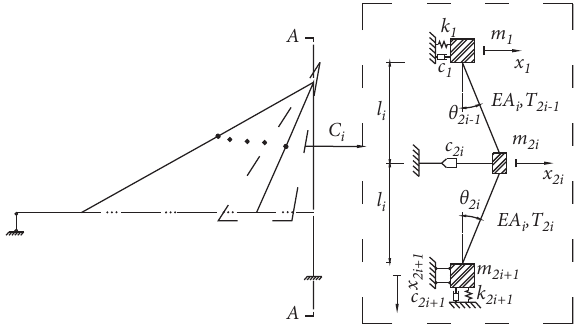
Figure 2: The i th simplified model in multidegrees of